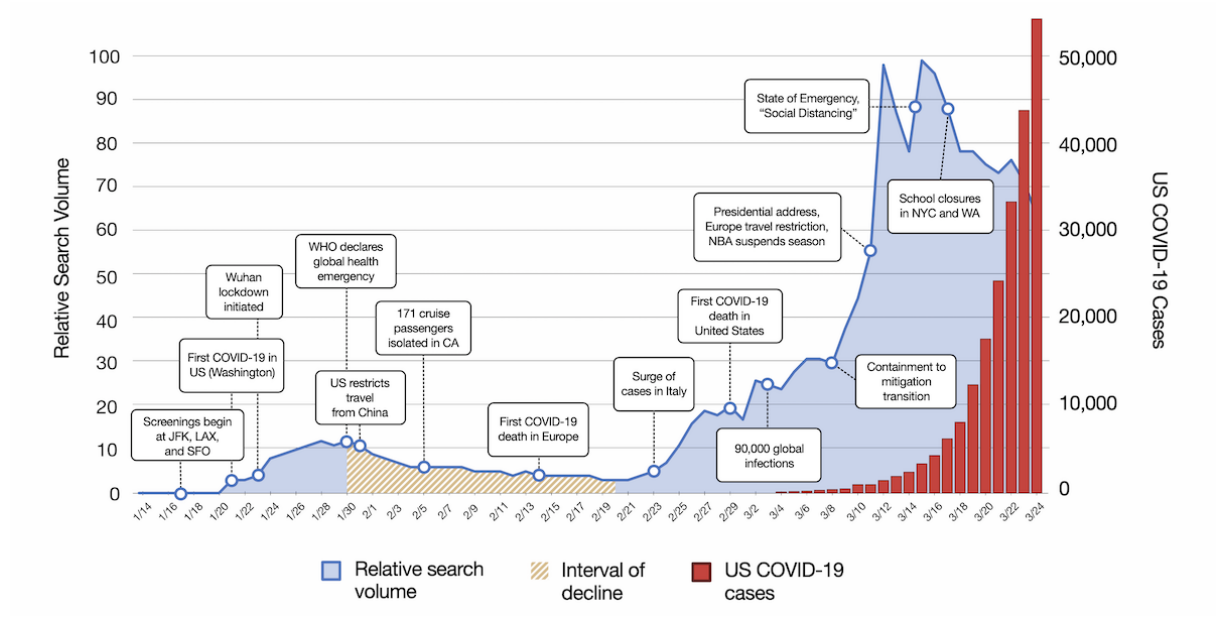
Figure 1. Google Trends RSV (0-100) of the keyword coronavirus in the United States graphed over time and during the period of rising COVID-19 cases. Key events are shown on the timeline between January 14, 2020 and March 24, 2020, and the interval decline in search interest is highlighted. COVID-19: coronavirus disease. CA: California. COVID-19: coronavirus disease. JFK: John F. Kennedy International Airport. LAX: Los Angeles International Airport. NBA: National Basketball Association. NYC: New York City. SFO: San Francisco International Airport. US: United States. WA: Washington. WHO: World Health